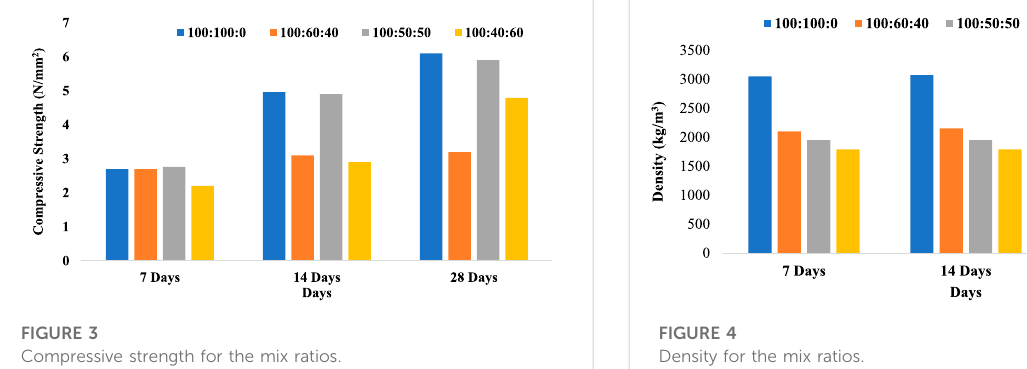
FIGURE 3 Compressive strength for the mix ratios.